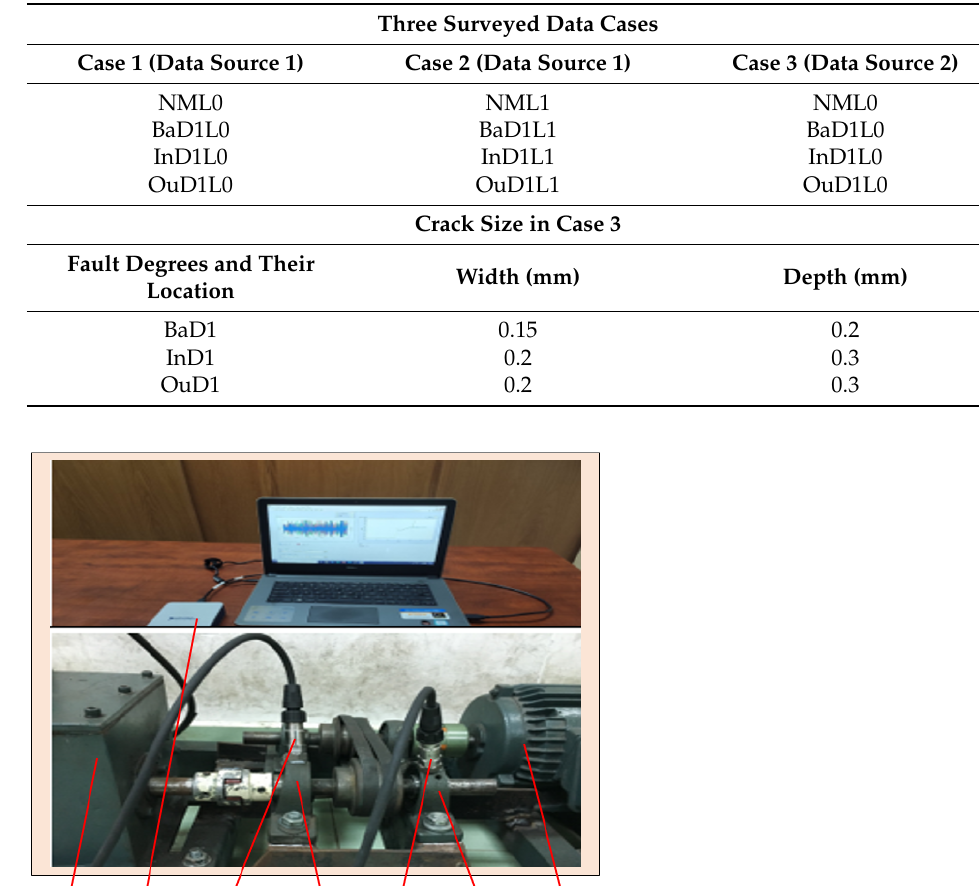
Table 2. Three surveyed data cases and crack sizes in Case 3.